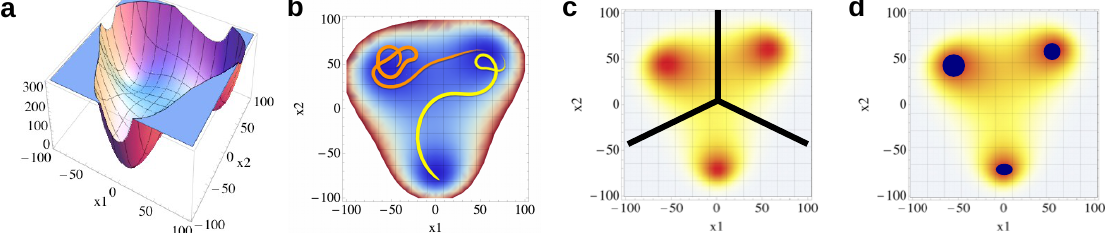
Figure 1. ( a ) Potential energy surface (PES) spanned by two coordinates x 1 and x 2; ( b ) trajectories within the PES (projection onto x 1 and x 2); ( c ) Boltzmann distribution of the PES divided into three states; ( d ) core sets ( blue ) within the Boltzmann distribution; all non-assigned data points are outside the core